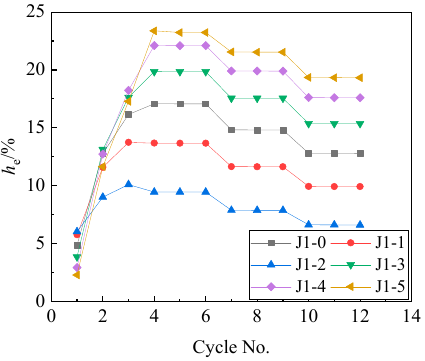
Figure 19. Equivalent viscous damping ratio–cycle no. curves.